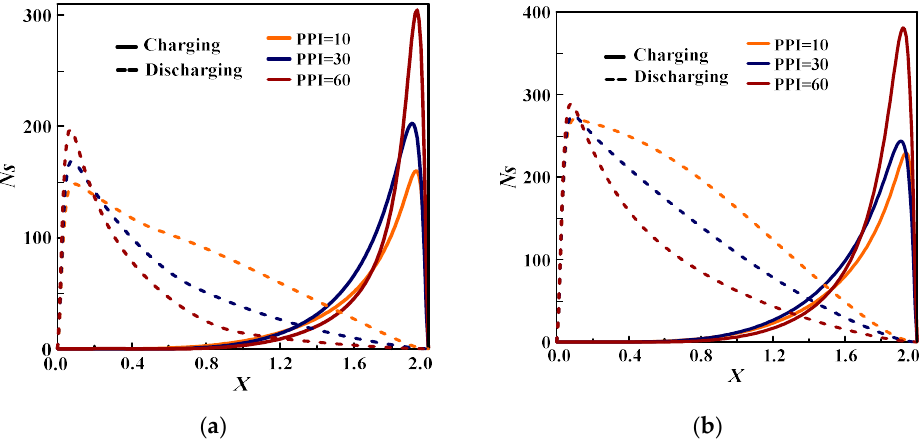
Figure 9. Pore density effect on the dimensionless entropy generation rate during charging and discharging processes at ε = 0.8: ( a ) Re = 200; ( b ) Re = 400.